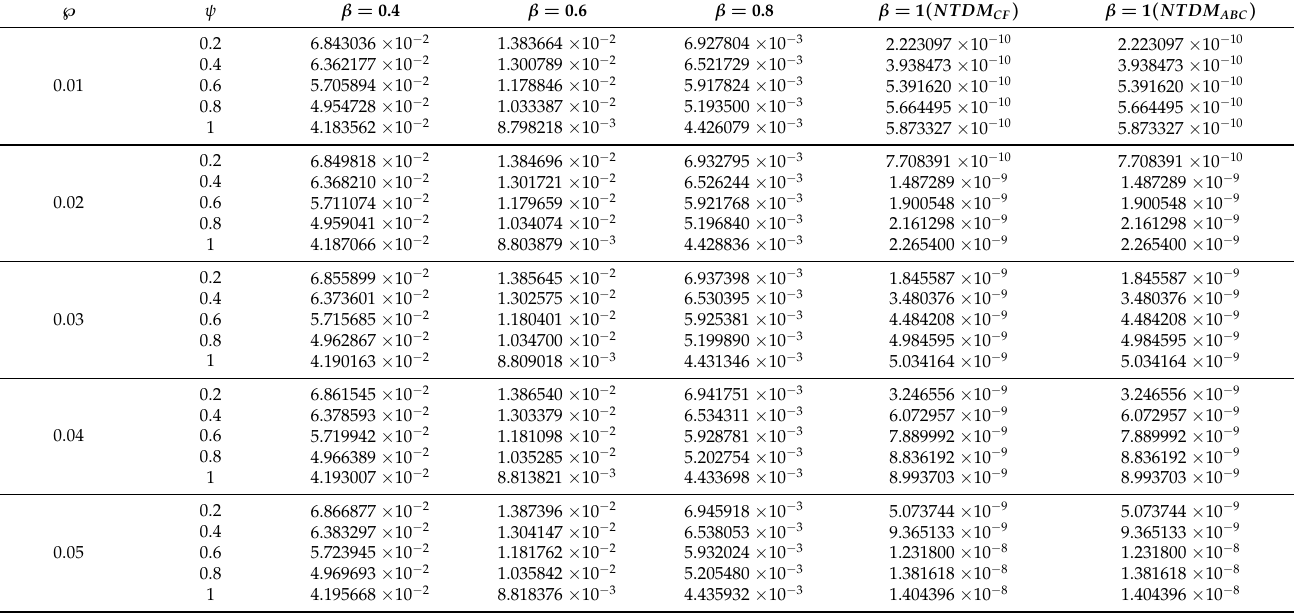
Table 3. Absolute error comparison of problem 2 at various fractional orders of β